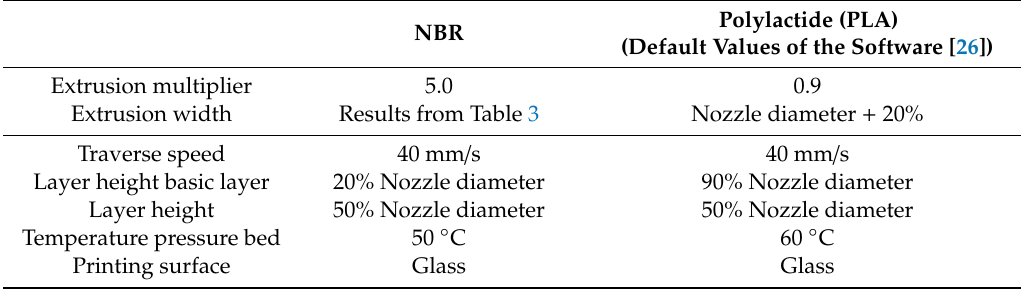
Table 4. Printing parameters for NBR compared with PLA.